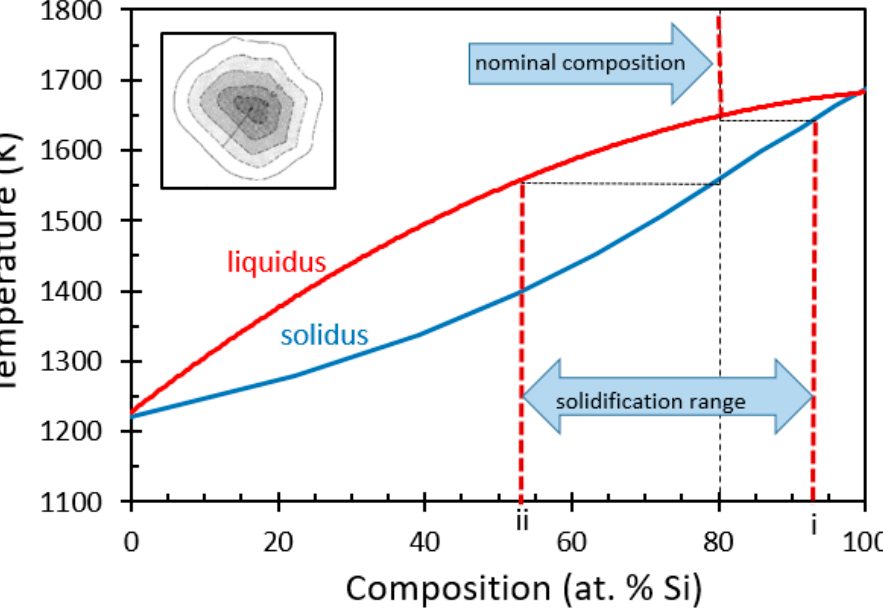
Figure 2. Binary equilibrium Si-Ge phase diagram showing solidification range for a nominal liquidus composition of Si-80% Ge-20% (atomic) [15]. (Typical cored microstructure is diagrammed in the insert). Composition “i” is the first solid to freeze-out; composition “ii” is the last solid to